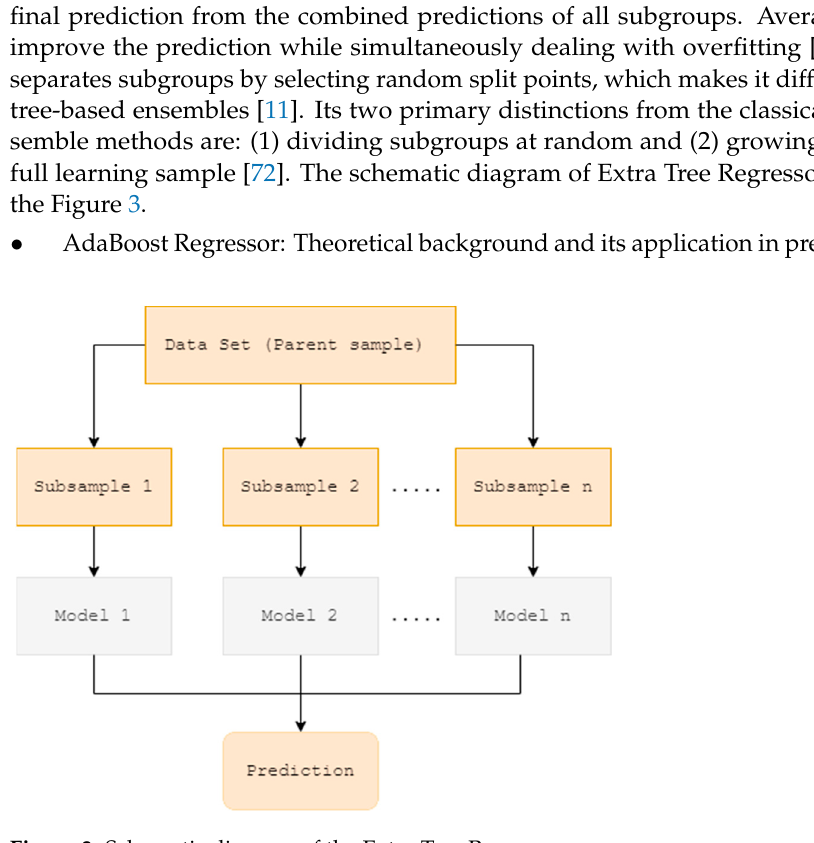
Figure 3. Schematic diagram of the Extra Tree Regressor.